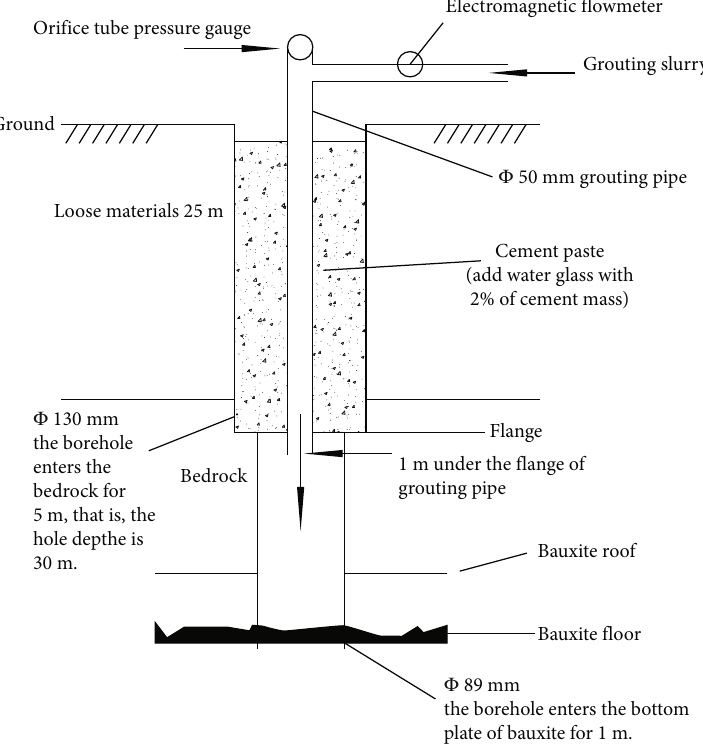
Figure 10: Structure of grouting